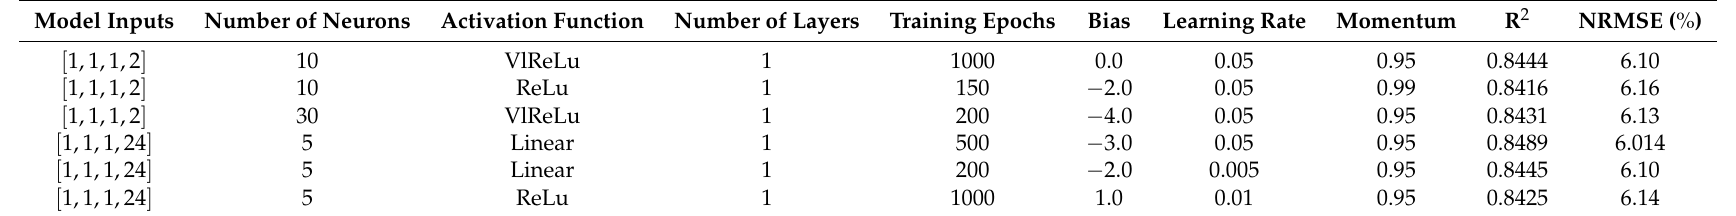
Table 4. Best results among the DHN models with minimal